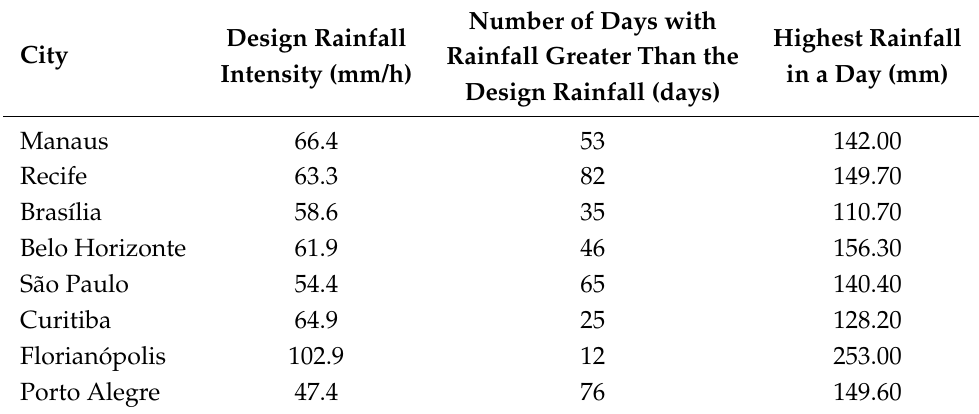
Table 6. Intensity-Duration-Frequency and hydraulic data for each city.